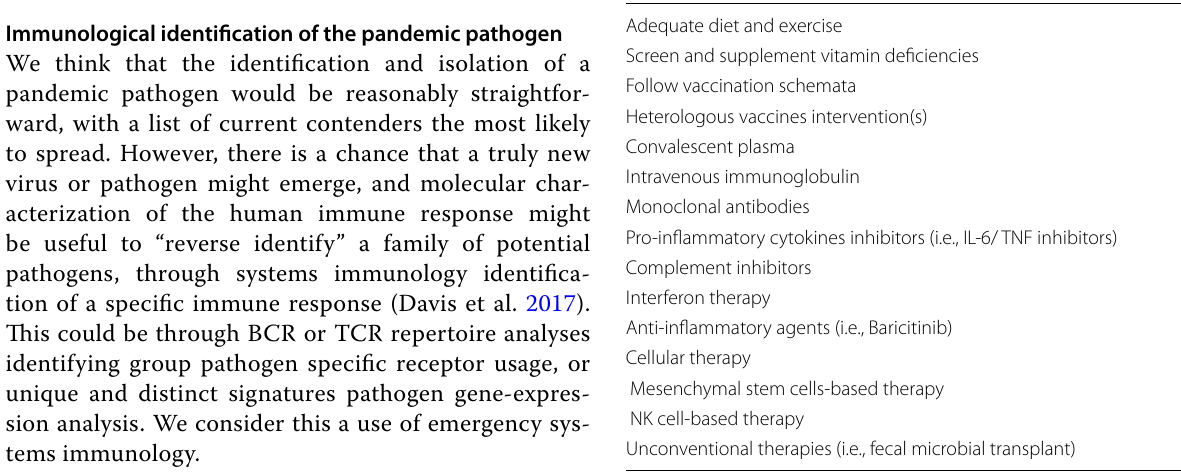
Table 1 Immunological therapeutic